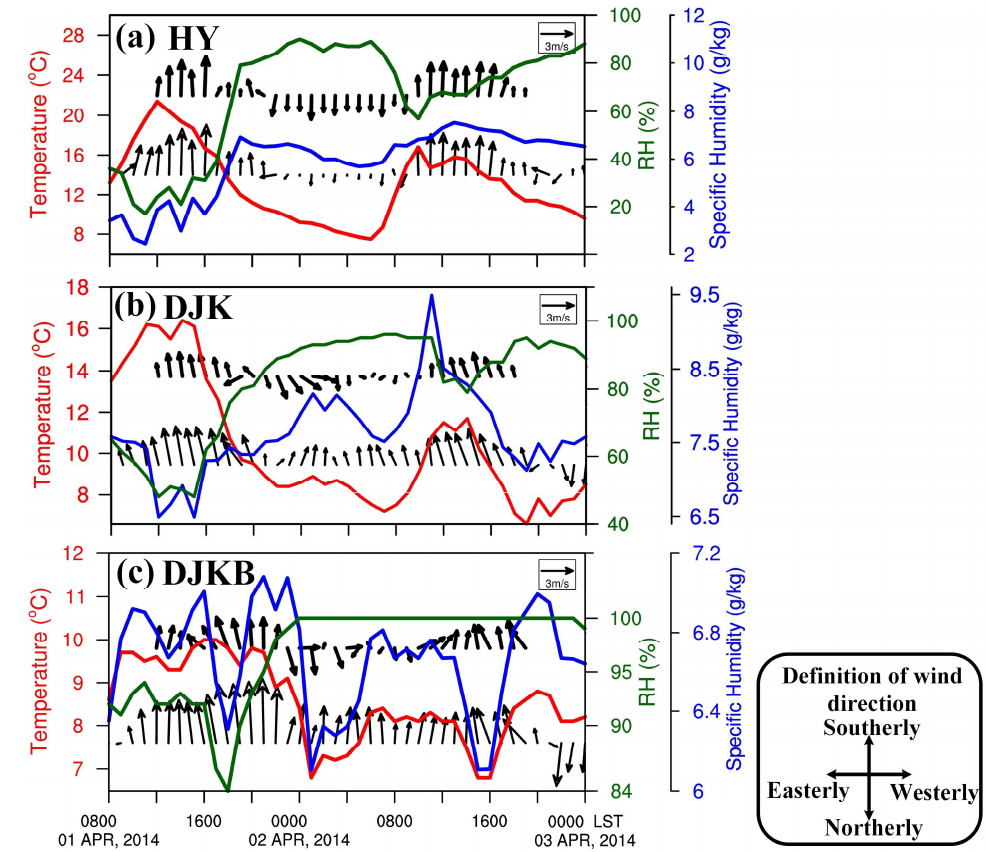
Figure 4. Time series of hourly surface measurements at the stations: HY ( a ), DJK ( b ), and DJKB ( c ). Variables were the 2-m air temperature, relative humidity, and specific humidity. Lower vectors were the measured 10-m surface winds, while the upper vectors were surface winds with the 24-h average removed. Thick vectors are sea–land breezes.